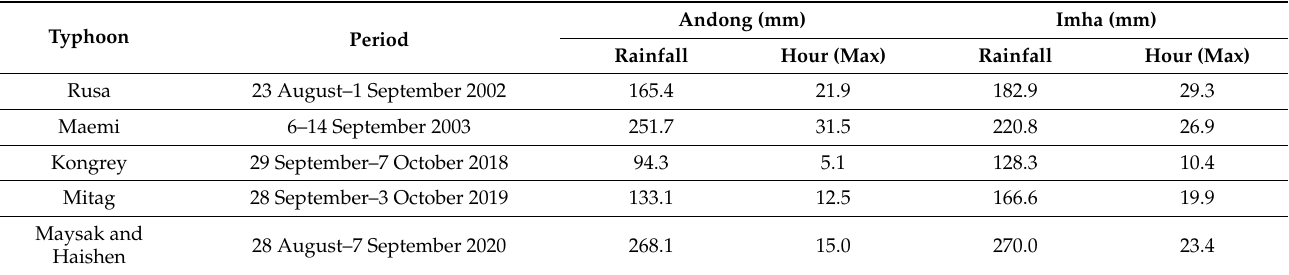
Table 9. Typhoon cases.